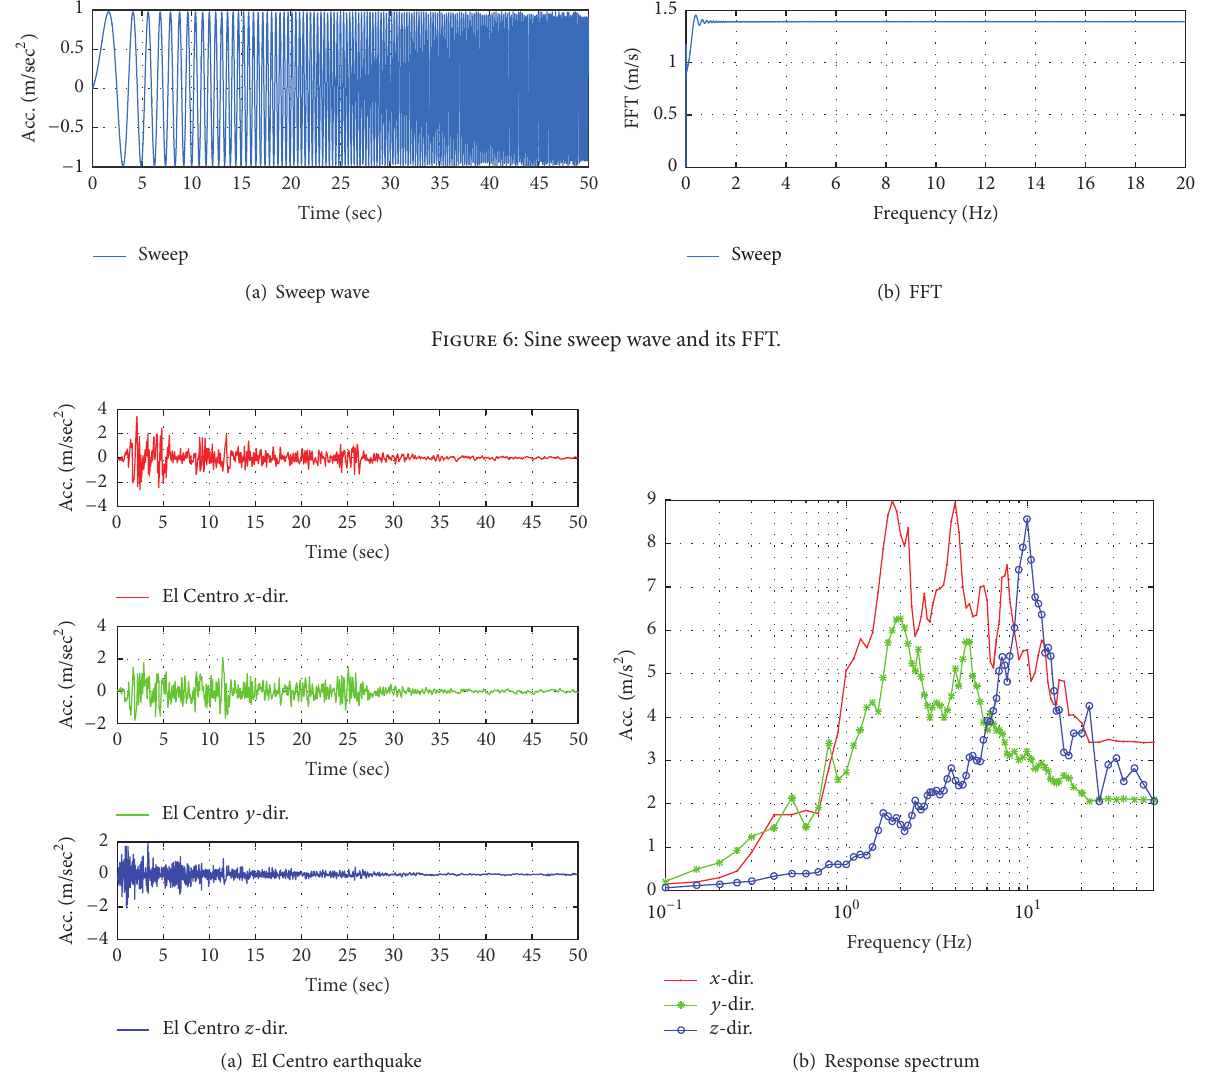
Figure 7: El Centro earthquake and its